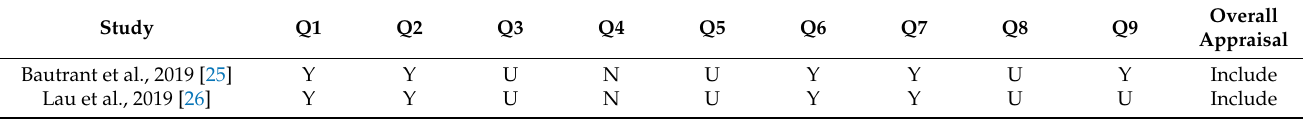
Table A8. The methodological quality assessment results of quasi-experimental studies.